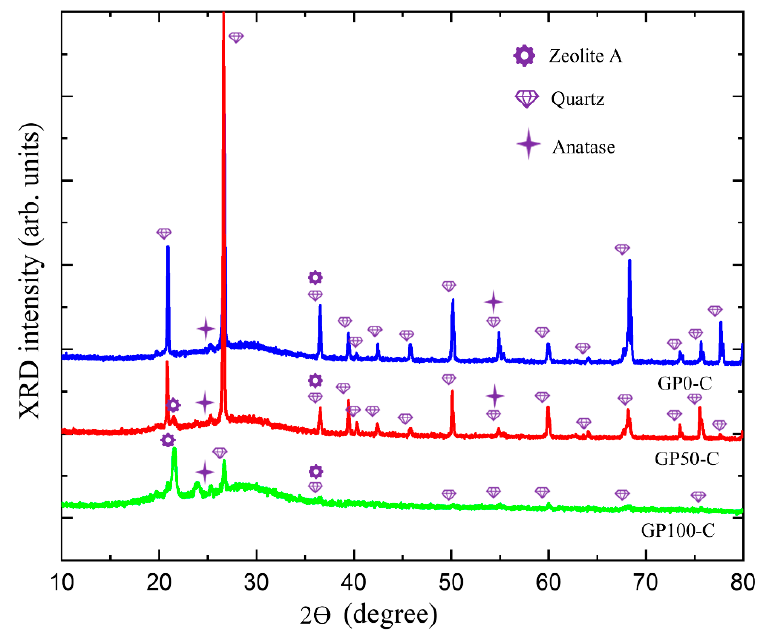
Figure 8. Diffractogram of the GP-C group mortars.